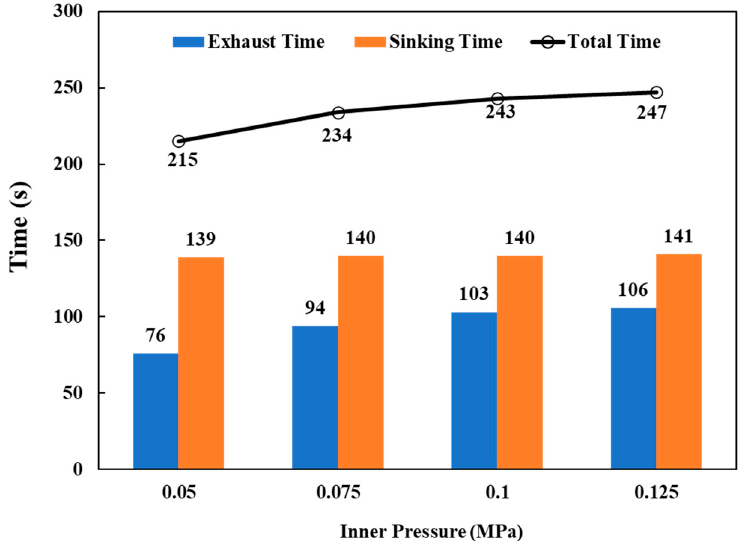
Figure 12. Time for sinking operation with different initial inner pressure.